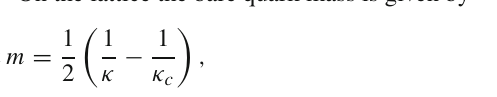
[43].Thebarequarkmass m bare iscomputedusingEq.(9). T and m bare are given in MeV, the lattice spacing a is given in fm and the inverse of the lattice spacing 1 / a in